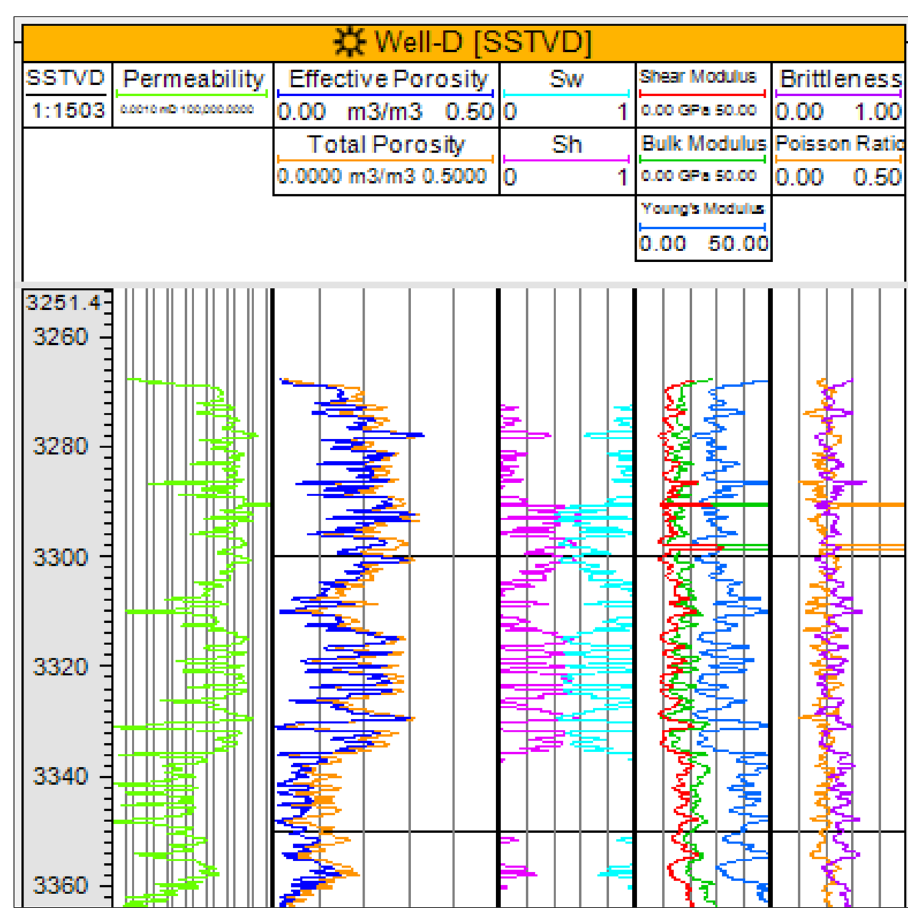
Fig. 15 Petrophysical